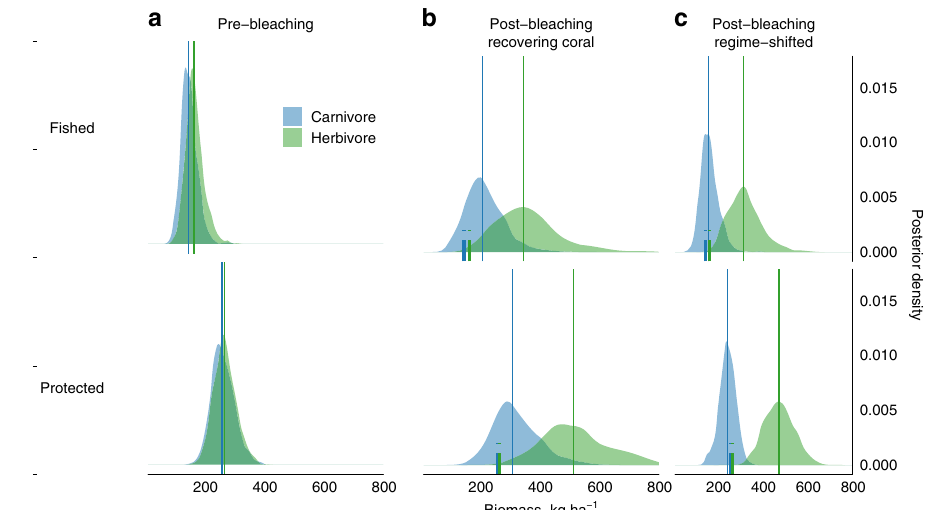
Fig. 5 Marine reserve effects on carnivore and herbivore biomass before and after coral bleaching. For fi shed (top) and protected (bottom) reefs, density curves are the posterior distributions of carnivore (blue) and herbivore (green) biomass before ( a ) and after bleaching for recovering coral ( b ) and regime-shifted ( c ) reefs. Vertical lines indicate median biomass, with short lines indicating median 1994 biomass on post-bleaching ( b , c ). See Supplementary Figs. 7 – 9 for pre- and post-bleaching posterior distributions at each reef, Supplementary Fig. 10 for posterior distributions including 2017 survey data, and Supplementary Fig. 11 for observed biomass